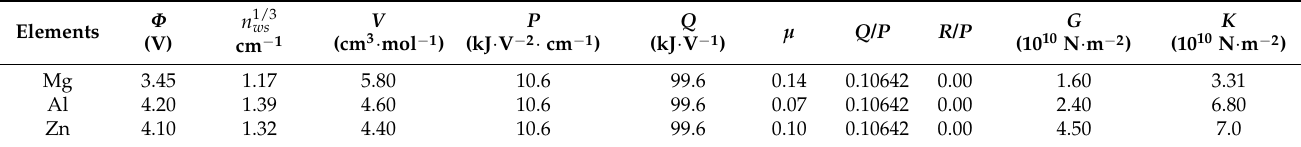
Table 4. Parameters for the thermodynamic calculations of Mg-Al-Zn system [40,42,45–47].